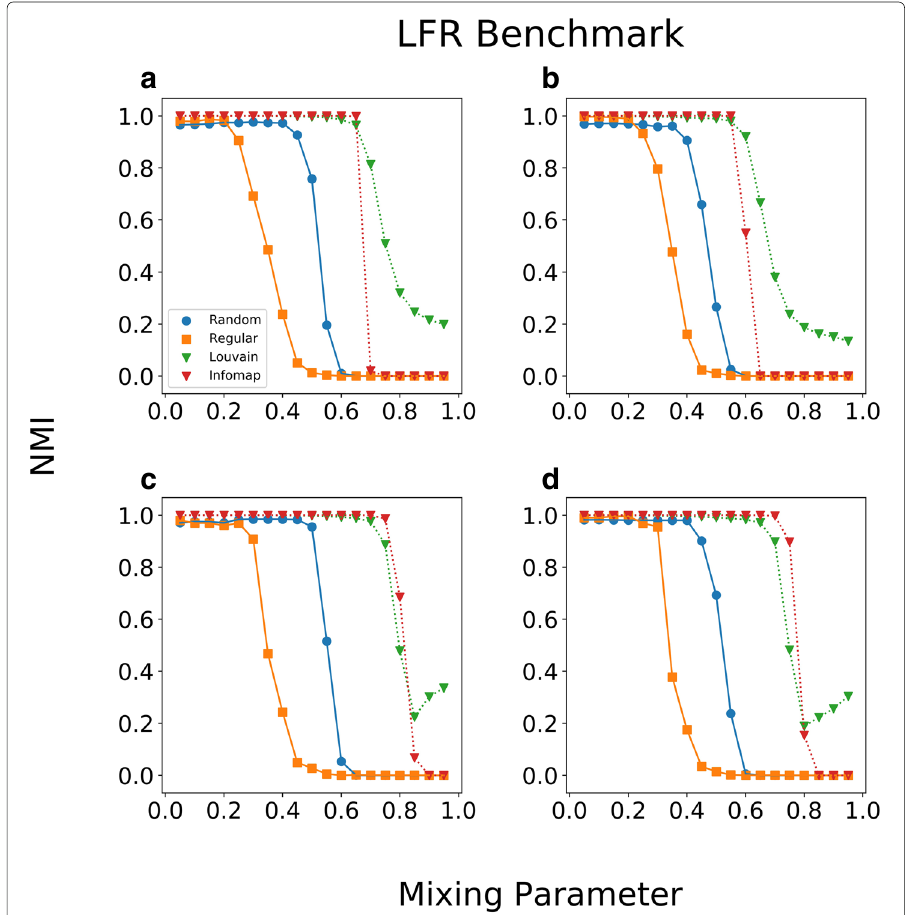
Fig. 5 Performance of the community detection algorithm on the Lancichinetti-Fortunato-Radicchi (LFR) benchmark graph. We display results only for the reduced version of the algorithm but with both initial conditions. As a term of comparison, we display results obtained by Louvain and Infomap in the same set of benchmark graphs. In the various panels, performance is measured in terms of normalized mutual information (NMI). This quantity is evaluated as a function of the mixing parameter μ of the model. We consider the following experimental settings: a Small communities with N = 1000 nodes; b Big communities with N = 1000 nodes; c N = 5000 nodes with Small communities; d N = 5000 nodes with Big